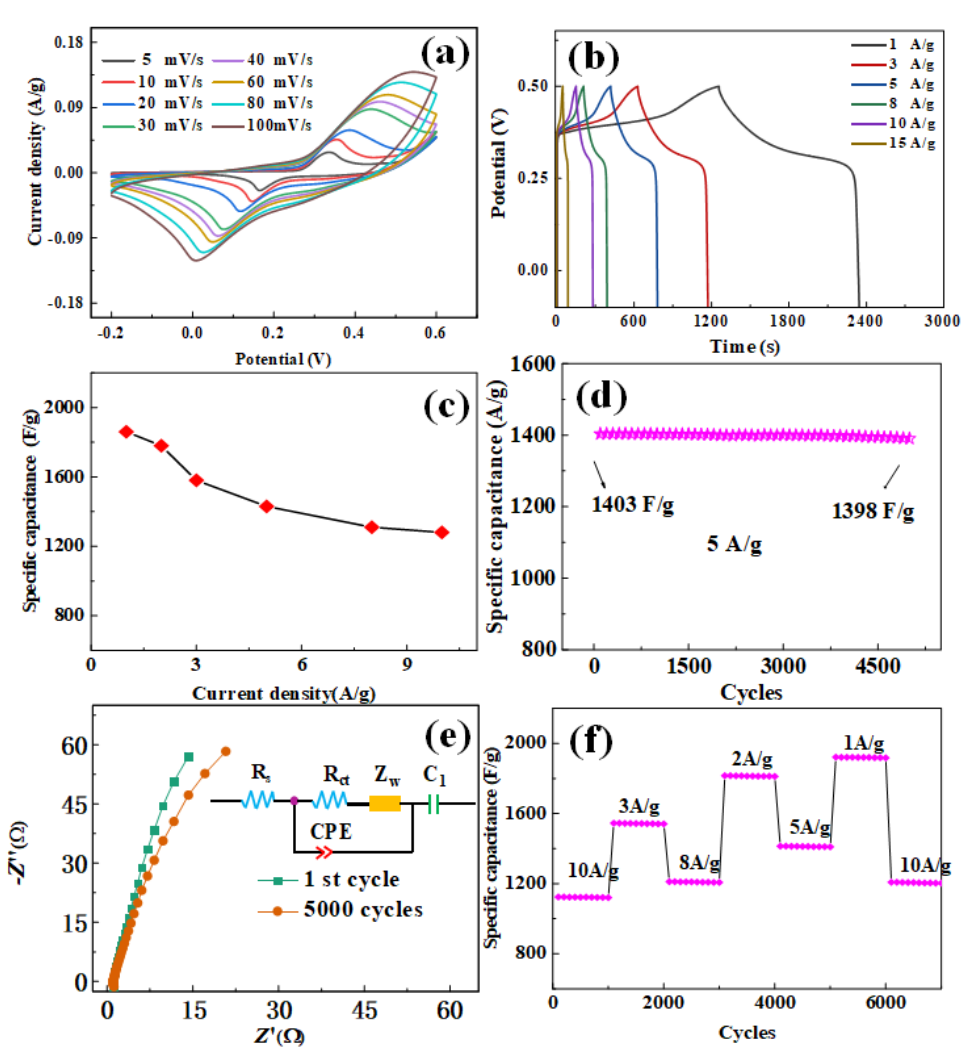
Figure 5. Electrochemical characterization of the Co 3 O 4 nanosheets in a three − electrode system. ( a ) CV curves of Co 3 O 4 nanosheets. ( b ) Charge-discharge curves of Co 3 O 4 nanosheets at current densities of 1, 3, 5, 8, 10, and 15 A/g. ( c ) Specific capacitance of Co 3 O 4 nanosheets at different current densities. ( d ) Cycle performance test of Co 3 O 4 nanosheets at a current density of 5 A/g. ( e ) Nyquist diagram of the first cycle and after 5000 cycles of Co 3 O 4 nanosheets. ( f ) Rate and cycle performance of the hybrid Co 3 O 4 nanosheets under varied current densities. Table 1. The capacitance properties of the synthetic materials in this experiment are compared with those of the references.